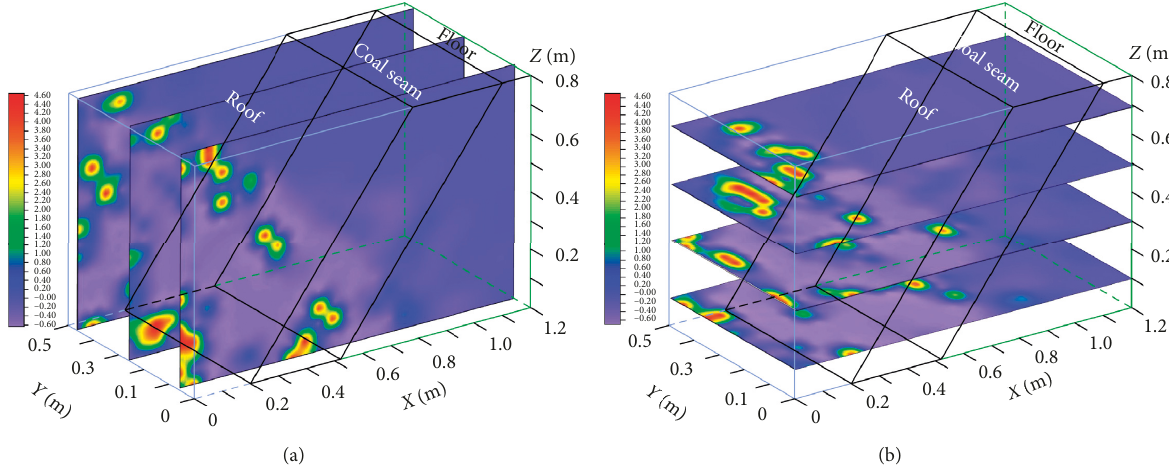
Figure 7: Tomographyresultsinthe test.(a)AEvelocitydistributionin theverticaldirection.(b)AEvelocity